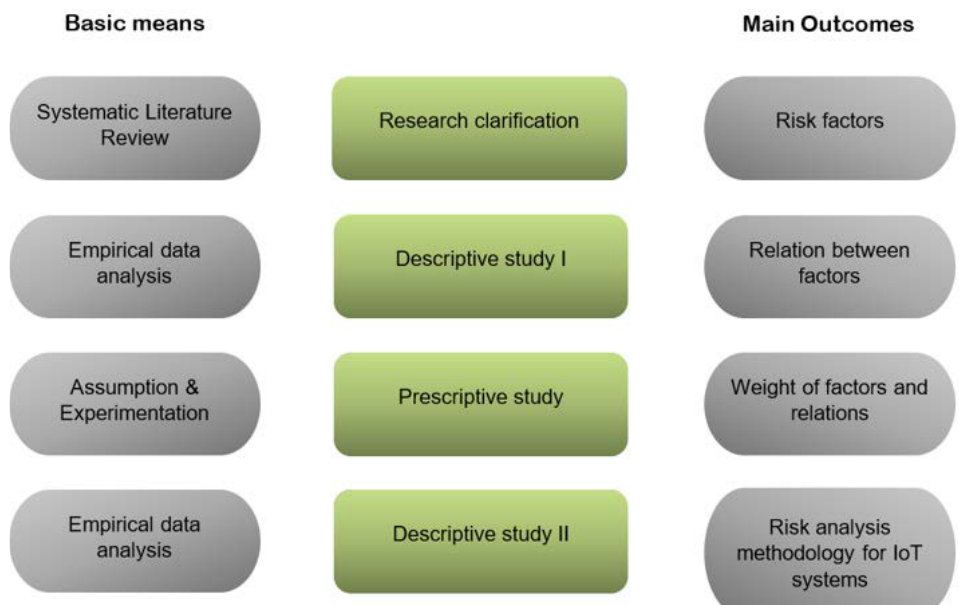
Figure 1. Phases of Design Research Methodology (DRM) to development risk analysis methodology for IoT systems.